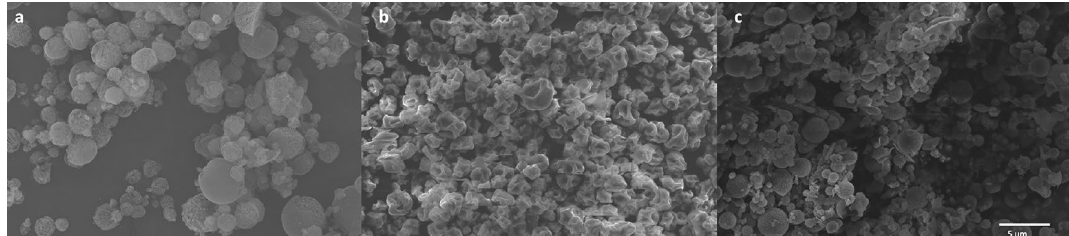
Figure 4. Morphology of different dehydrated insulin NPs stored for three months: ( a ) SEM image of freeze- dried insulin NPs with mannitol; ( b ) SEM image of spray-dried insulin NPs without mannitol; ( c ) SEM image of spray-dried insulin NPs without mannitol.